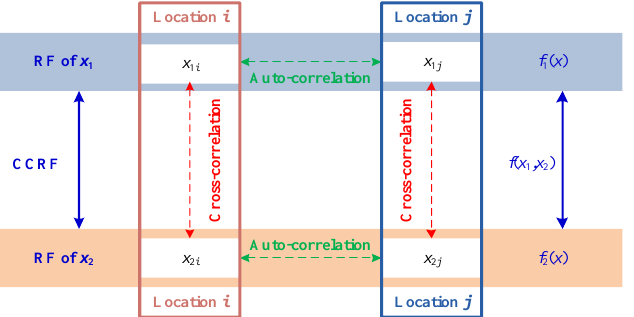
Figure 2. Schematic diagram of correlations among soil parameters.